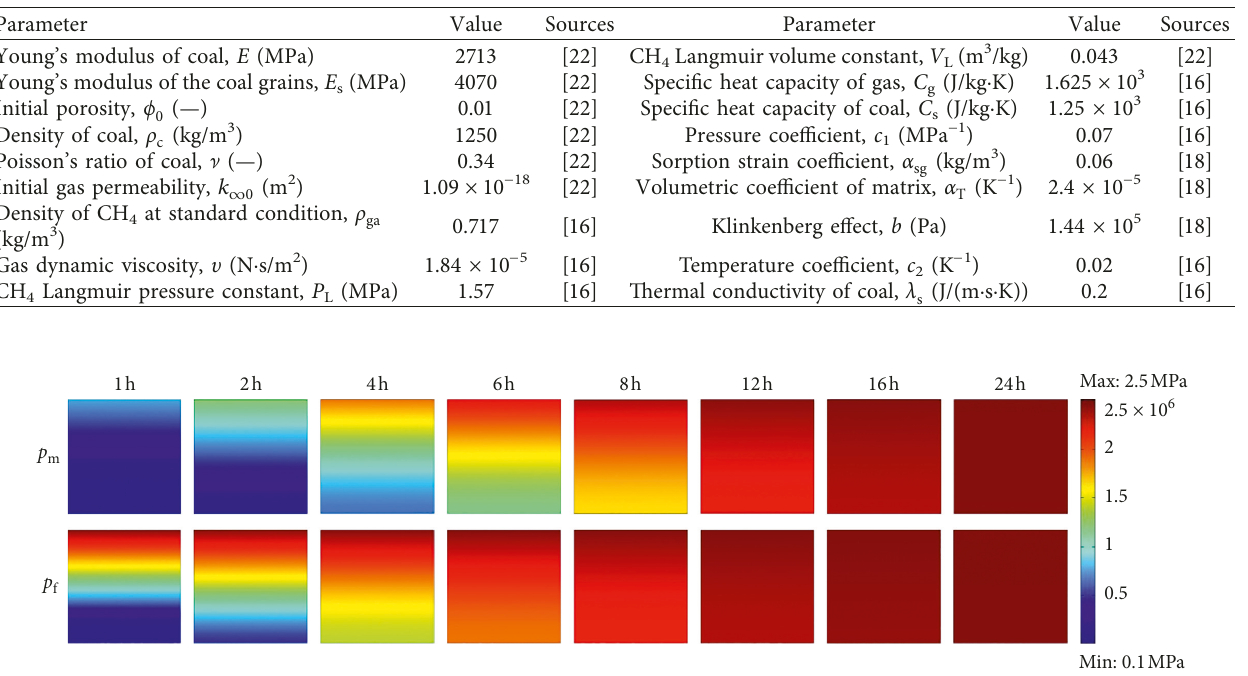
Figure 5: Gas pressure change law of the model.